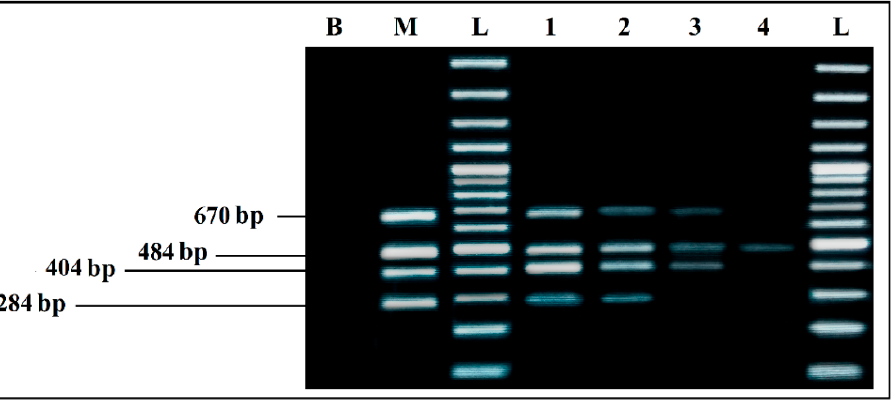
Figure 6. Detection sensitivity of mPCR from individual cultures. B, negative control; M, mPCR positive control; L, 100 bp DNA ladder; lane 1, mPCR detection with mix DNA (100–70 pg/ μ L) for each target; lane 2, mPCR detection with mix DNA (10–8 pg/ μ L) for each target; lane 3, mPCR detection with mix DNA (5–1 pg/ μ L) for each target; lane 4, mPCR detection with mix DNA (0.6–0.1 pg/ μ L) for each target; L, 100 bp DNA ladder.